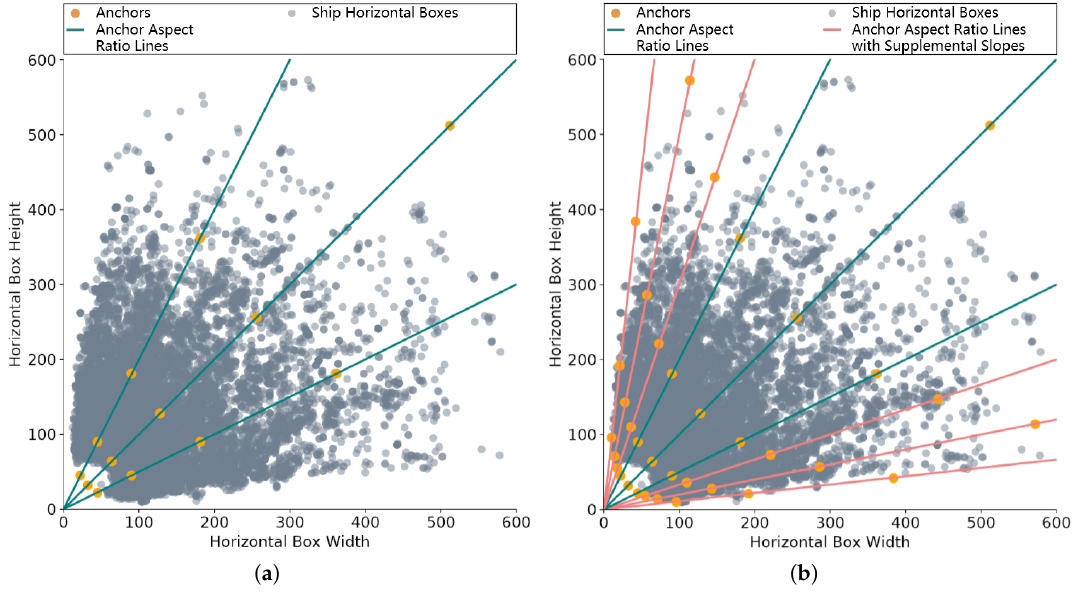
Figure 10. Distribution Comparison of anchors with different aspect ratios. ( a ) scatter plot of ship horizontal boxes (gray dots), scatter plot of anchors (yellow dots), and green lines with 1/2, 1.0 and 2.0 slopes used in traditional object detection; ( b ) anchor ratios are 1/9, 1/5 1/3, 1/2, 1.0, 2.0, 3.0, 5.0 and 9.0. Scatter plot of ship horizontal boxes (gray dots), scatter plot of anchors (yellow dots), green lines with 1/2, 1.0 and 2.0 slopes, and red lines with 1/9, 1/5, 1/3, 3.0, 5.0 and 9.0 slopes supplemented for object detection of large aspect